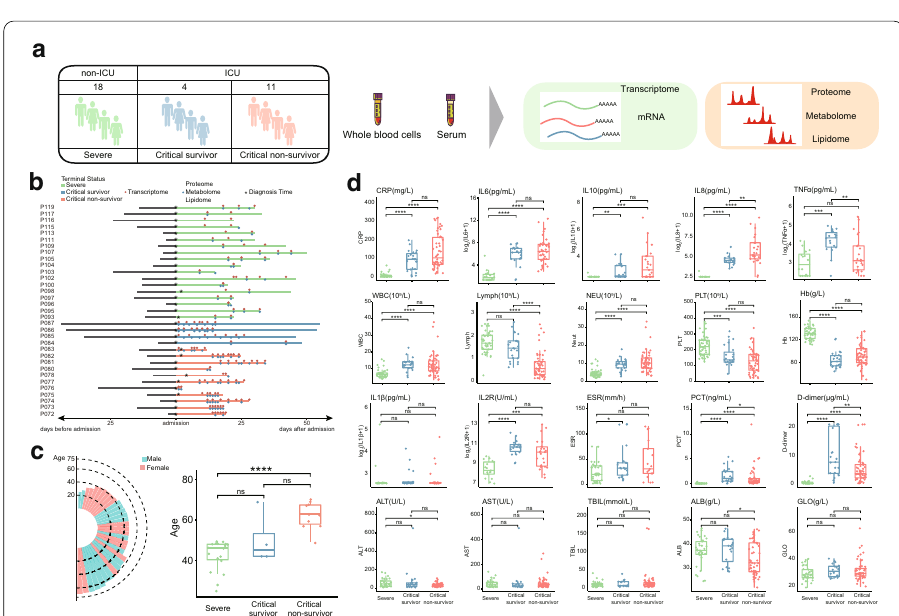
Fig. 1 Patient enrollment, study design and different clinical parameters of COVID-19 patients. a Summary of recruited COVID-19 patients, including 18 severe patients, 4 critical survivors, and 11 critical non-survivors. b Admission days and multi-omics sample collection time of COVID-19 patients. Datasets contained 113 transcriptome, 85 proteome, 85 metabolome, 85 lipidome were collected from 33 patients. Grey bar records time from disease onset to admission by weeks; colored bar records time from admission to outcome-time-point by days. Points represent multi-omics data sampling time. The details of enrolled patients were shown in Additional file 1: Table S1. c The age and gender distribution and comparison of 33 COVID-19 patients. * p < 0.05. d The clinical parameters of COVID-19 patients. 123 clinical data were collected. **** p < 0.0001, *** p < 0.001, ** p < 0.01, * p < 0.05. WBC, white blood cells; Lymph, lymphocyte; NEU, neutrophil; PLT, platelet; Hb, hemoglobin; ALT, alanine transaminase; AST, aspartate aminotransferase; TBIL, total bilirubin; ALB, albumin; GLO, globulin; CRP, C-reactive protein; IL6, interleukin-6; IL10, interleukin-10; IL8, interleukin-10; TNFα, tumor necrosis factor alpha; IL1β, interleukin-1 beta; IL2R, Interleukin-2 receptor; ESR, erythrocyte sedimentation rate; PCT, procalcitonin; D-dimer, fibrin